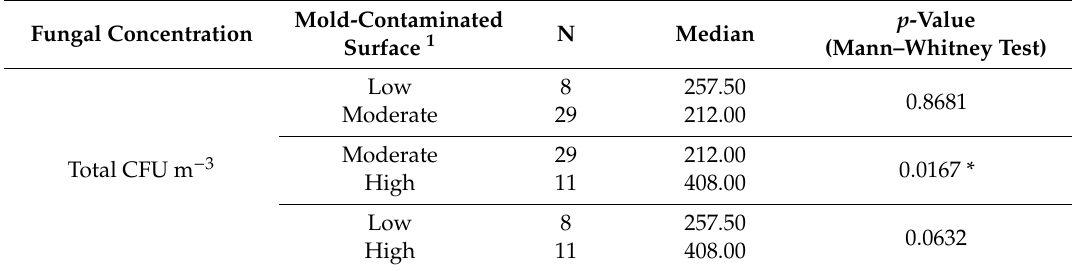
Table 5. Mold-contaminated surfaces as explanatory variables used to explain fungal concentrations observed in